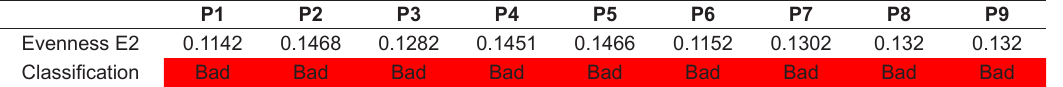
Table 5. Water quality classification of Broa reservoir according to Evenness E2 Index in 9 points (P1 to P9) along a longitudinal